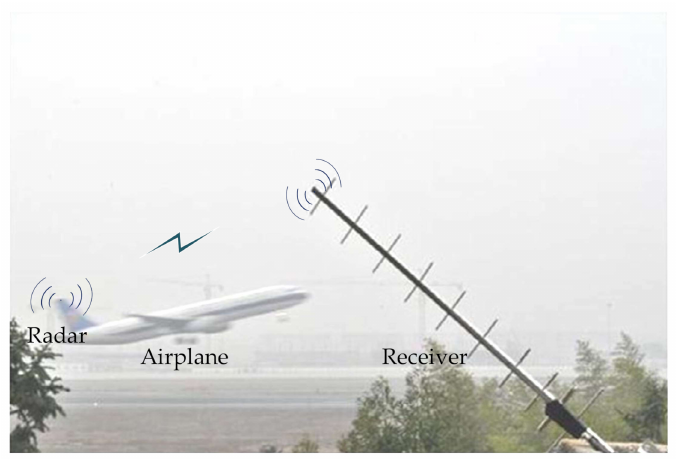
Figure 7. The environment of the signal collecting experiment. After signal truncation and sample sieving, a dataset of 20 devices is obtained. Each device environment is comprised of 240 samples, each of which contains 128 sampling points. The software employed in this experiment includes Python 3.8.0, Pytorch 1.6.0, NVIDIA Cuda 10.2, and NVIDIA Cudnn 7.6.5. The model is run on a PC equipped with an Intel Xeon Gold 6230R CPU at 2.10 GHz, 128 GB of RAM, and an Nvidia Tesla